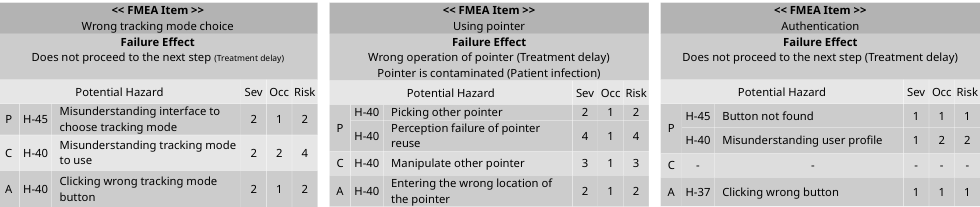
Figure 9. Risk analysis for sinus surgical navigation